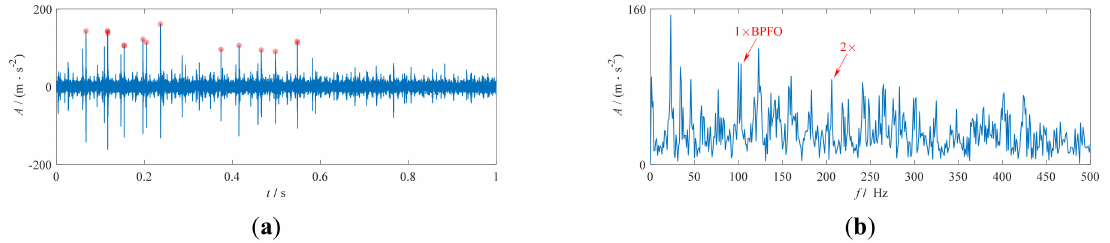
Figure 13. The signal from Curtin University: ( a ) TDW and ( b ) SES.